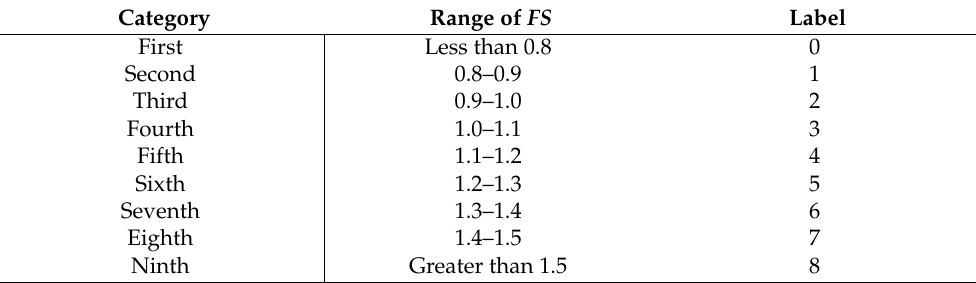
Table 1. Categories of FS values and their associated labels for multiclass classification. Category Range of